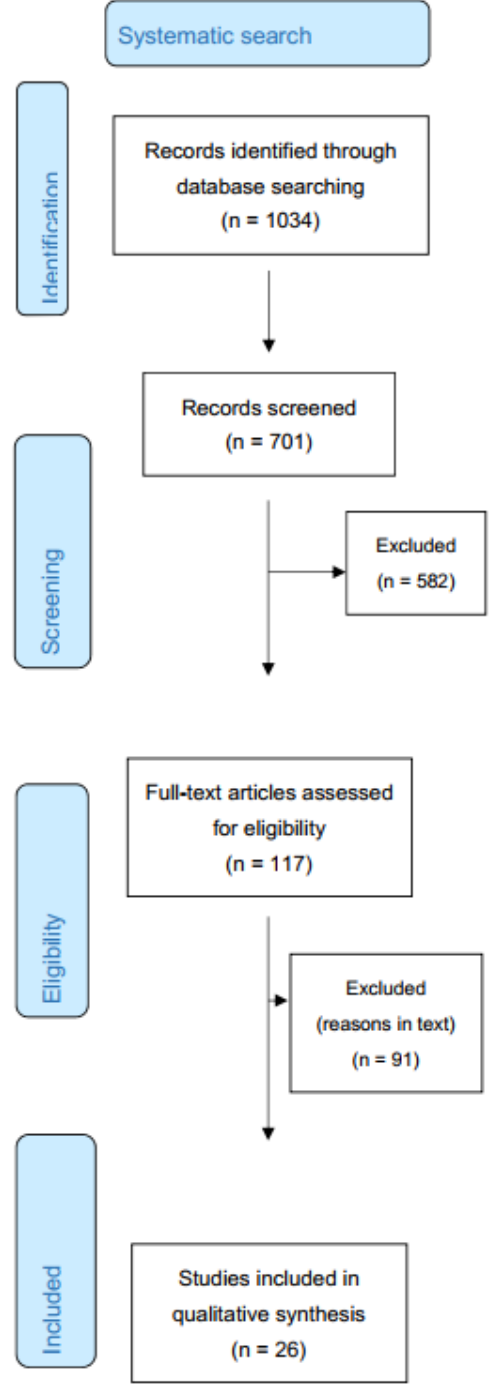
Figure 1. Flow chart literature search. Articles reporting at least two different prophylactic regimens of vit K in neonates were retained. Based upon the research question, 26 articles were retained in the final literature review, 11 registry studies and 15 clinical trials. An overview of these articles is provided in Table